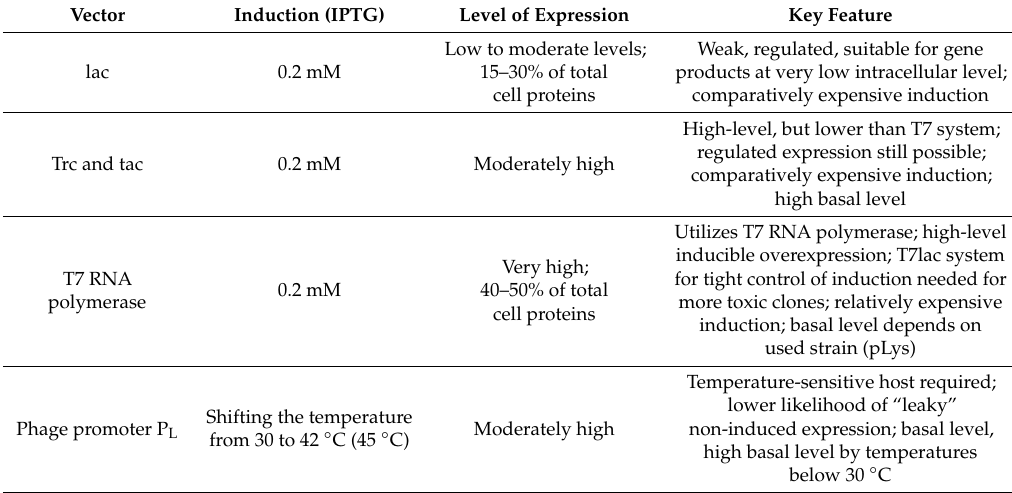
Table 5. Vectors based on di ff erent promoters used for heterologous protein production and their